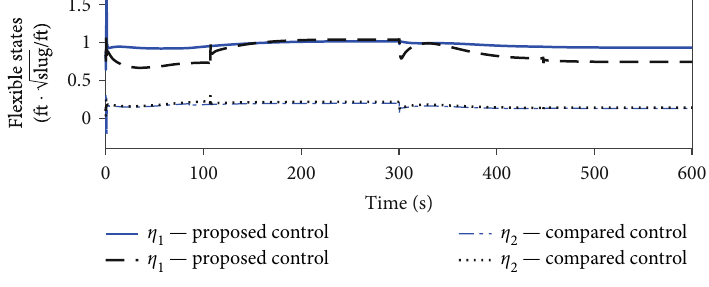
Figure 4: Flexible states in the comparison